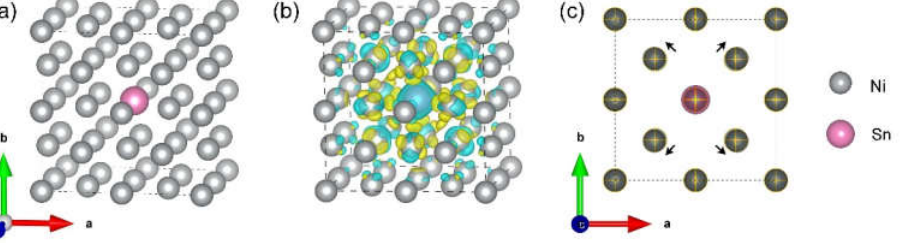
Figure 5. ( a ) Supercell structure of Ni 31 Sn, ( b ) differential charge density diagram of Ni 31 Sn; ( c ) atomic displacements before and after doping.